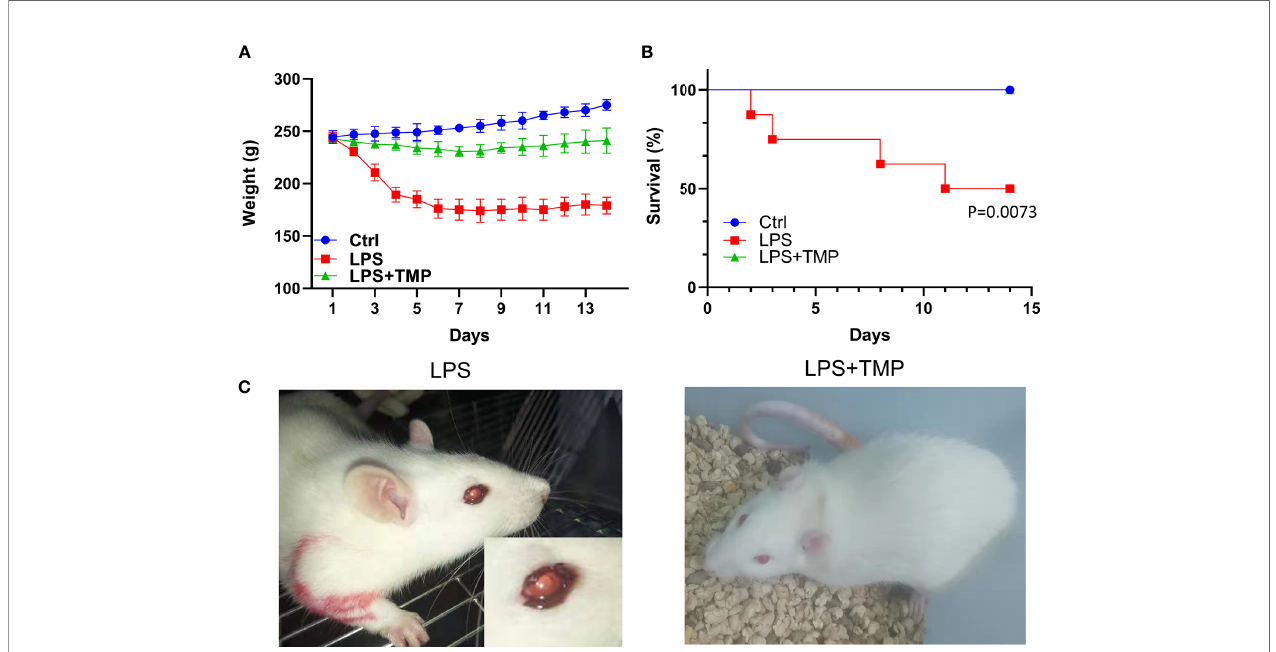
FIGURE 1 | Weight change and survival rate of rats with LPS-induced sepsis. (A) The trends of weight changes of rats in the control group, LPS group and LPS +TMP group for 14 days; (B) The survival rates of each group for 14 days. (C) Modeling and enlarged eye detail of rats in the LPS and LPS+TMP groups 4 h after injection with LPS.